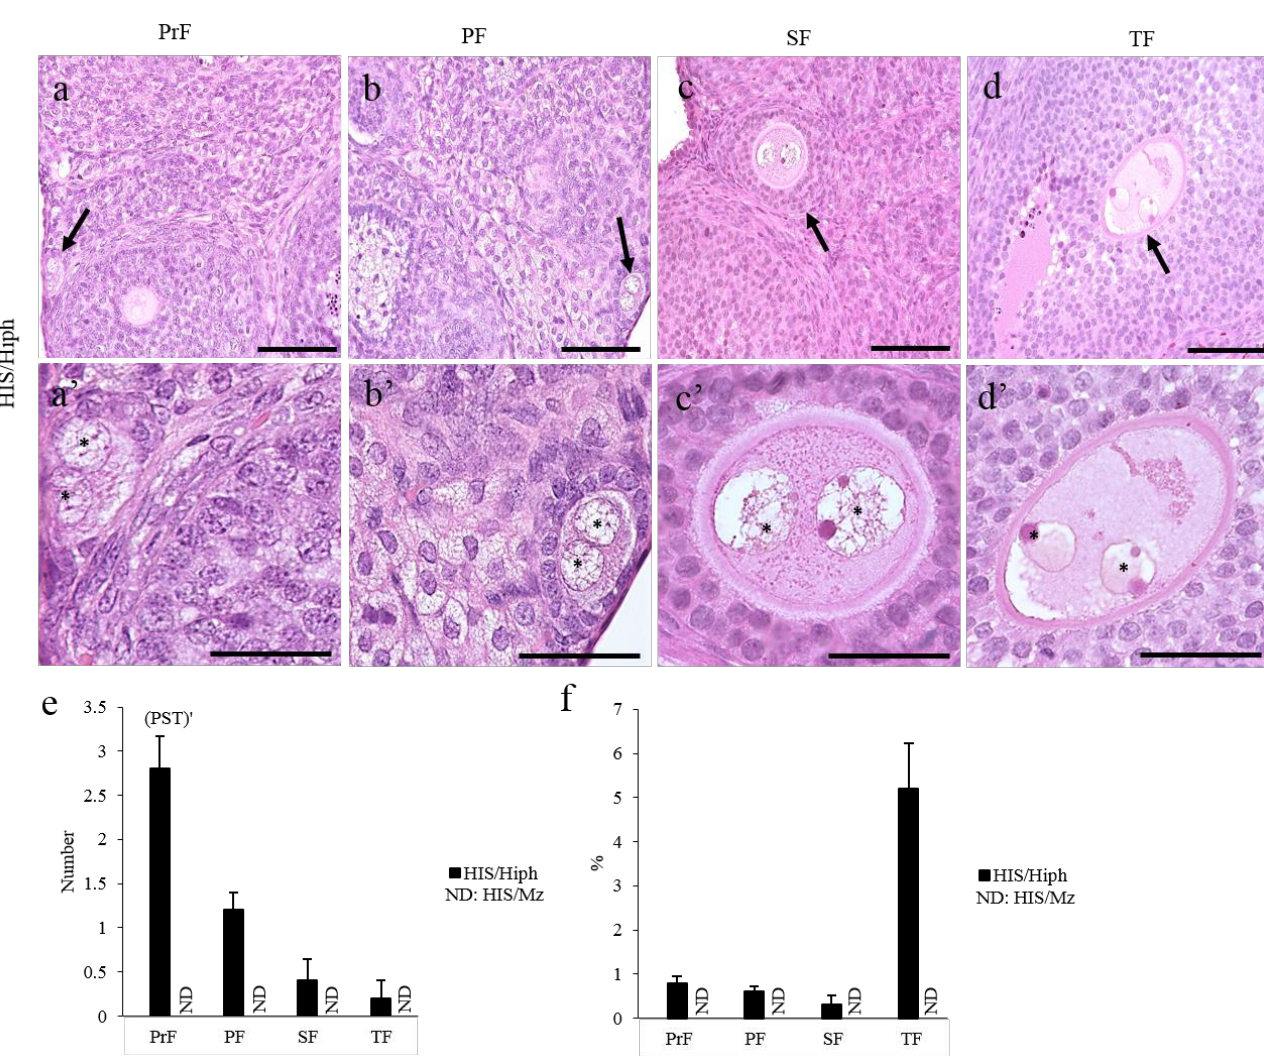
Figure 5. Double-nucleated oocytes (DNOs) in the ovaries of HIS/Hiph and HIS/Mz. ( a – d and a’ – d’ ) Histological observation of DNOs from hematoxylin–eosin-stained sections of the ovaries of 4-week-old HIS/Hiph and HIS/Mz. Two nuclei are observed within a single oocyte classified as primordial follicle (PrF), primary follicle (PF), secondary follicle (SF), and tertiary follicle (TF) in panels ( a – d ) (arrows) and ( a’ – d’ ) (magnified), respectively, but DNOs are absent in HIS/Mz. Each nucleus (asterisk) shares the same cytoplasm. Scale bars = 100 µm or 50 µm (magnified). ( e , f ) The total number and percentage of DNOs classified as developing follicles in the ovary of HIS/Hiph. Values are presented as the mean ± standard error. Pr, P, S, and T denote significant differences in the number of PrF, PF, SF, and TF, respectively, in HIS/Hiph (Kruskal–Wallis test followed by the Scheffé’s method, p < 0.05). Dashes beside letters indicate a highly significant difference ( p < 0.01). N = 5 in each age. ND: Not detected.